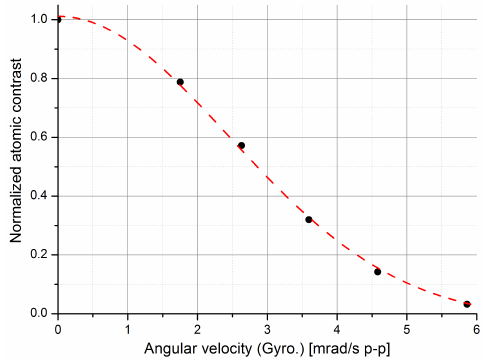
Figure 19. Contrast loss due to platform excitation with a sine actuation at 8.1 Hz around the Z axis. The angular velocity of the platform is measured thanks to a gyroscope. The red dashed line represents a Gaussian fit, in agreement with the expected contrast decrease. The interrogation time of the CAI is T = 46